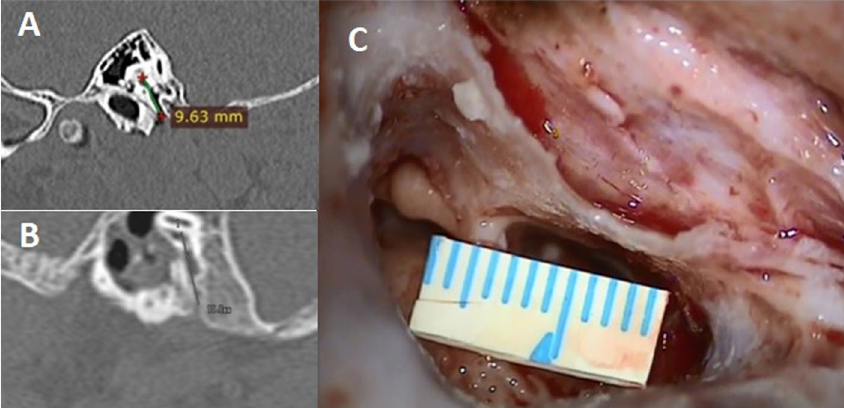
Fig. 2 A High-resolution computed tomography (HRCT) oblique sagittal cut showing a facial recess length of 9.63 mm (measured from most superior point of vertical segment of the facial nerve to branching point of chorda tympani), B HRCT curved MPR image showing a facial recess length of 10.8 mm (measured from most superior point of vertical segment of the facial nerve to branching point of chorda tympani), and C intraoperative view showing a facial recess length of 10